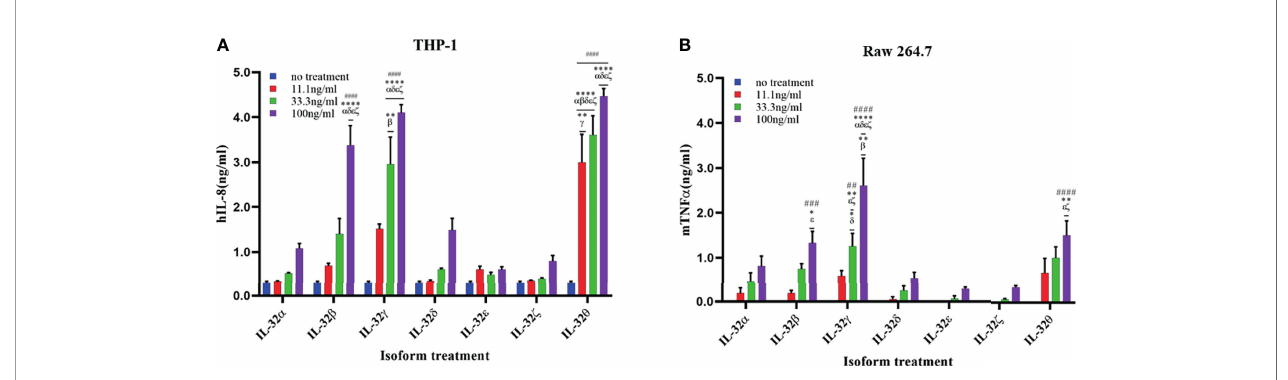
FIGURE 4 | Biological activities of seven rIL-32 isoforms in immune cell lines. rIL-32 isoforms with different concentrations were treated in cells for 18 h. The levels of IL-8 and TNF a were measured in the supernatant of THP-1 (A) and Raw 264.7 (B) , respectively, by using ELISA. The bar graph represents the level of cytokines, mean ± SEM. Statistical testing was performed using two-way ANOVA followed by Tukey ’ s post-hoc analysis. ## p < 0.01, ### p < 0.001, #### p < 0.0001 as compared to no treatment control within the same isoform treatment. * p < 0.05, ** p < 0.01, **** p < 0.0001 as compared to other displayed isoform symbols treated with the same concentration.